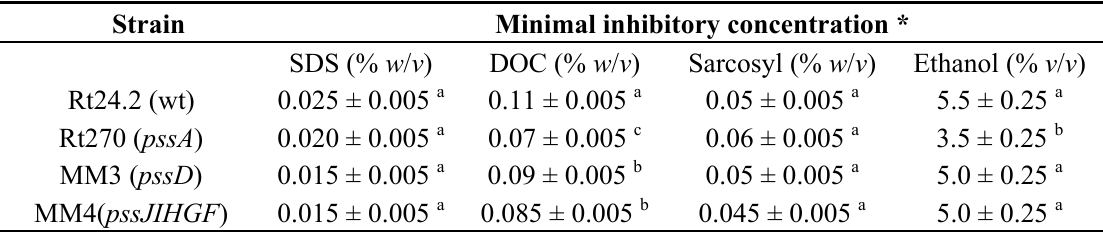
Table 3. Sensitivity of the wild-type Rhizobium leguminosarum bv. trifolii 24.2 and the mutant strains Rt270, MM3, and MM4 to various